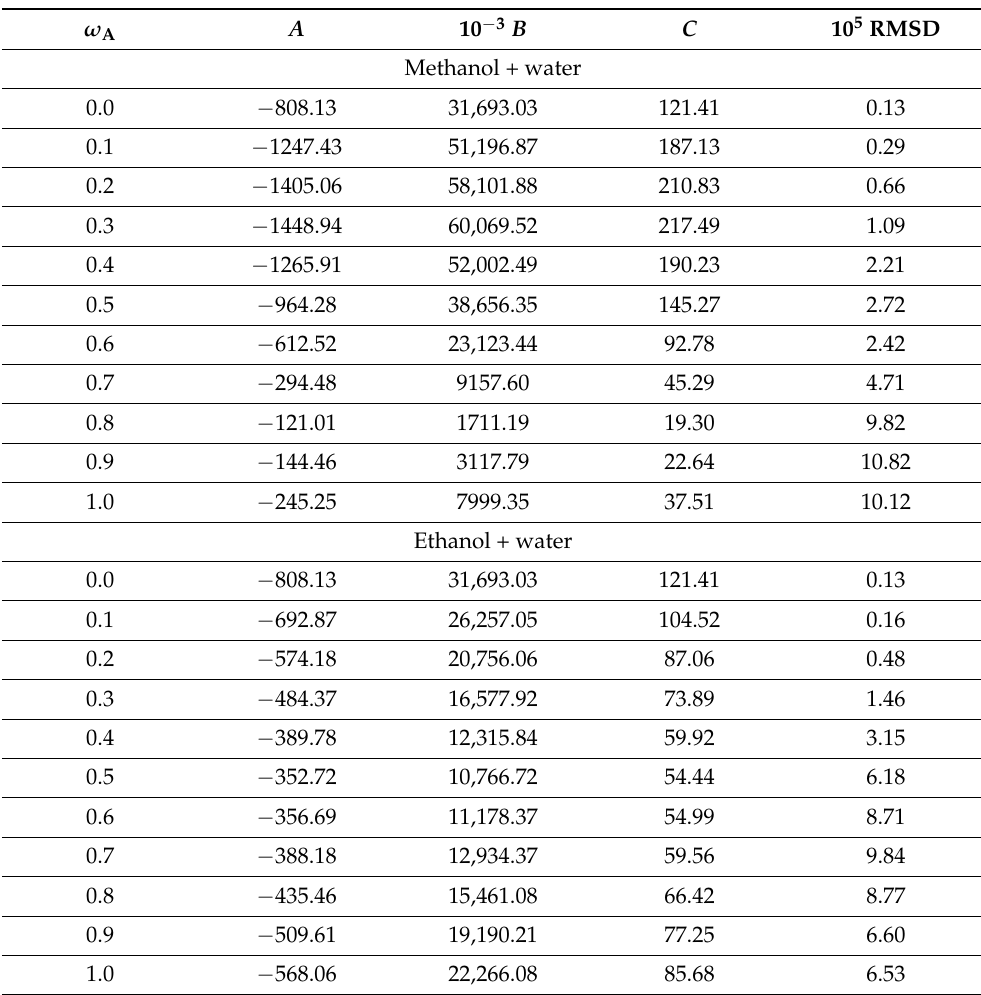
Table 5. Model parameters of modified Apelblat model for molar ratio solubility of florfenicol in binary solvents. ω